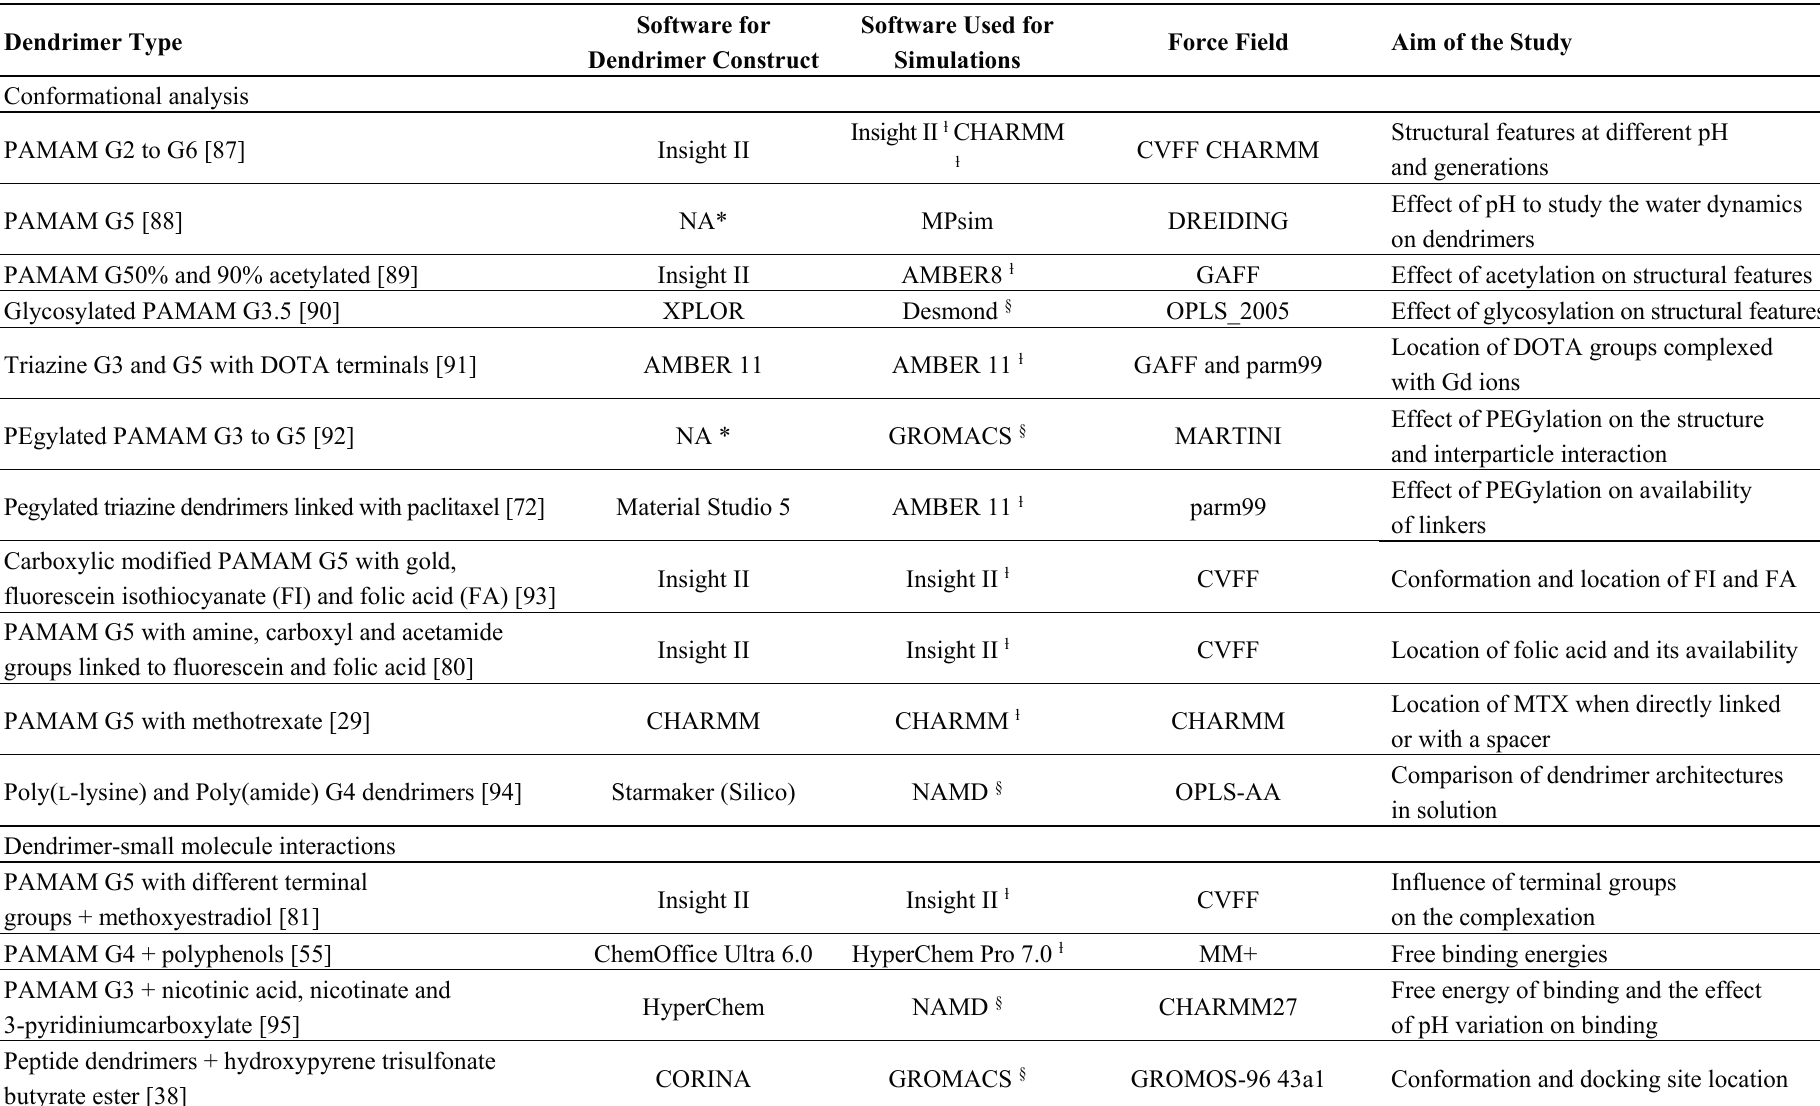
Table 1. Examples of software used to build and simulate different types of dendrimers; * NA: the software was not disclosed; § Free use; ƚ Commercial